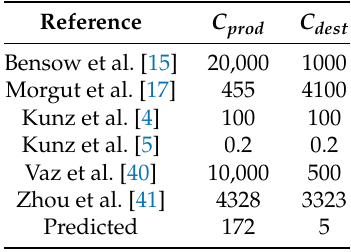
Table 5. Common values for C prod and C dest .